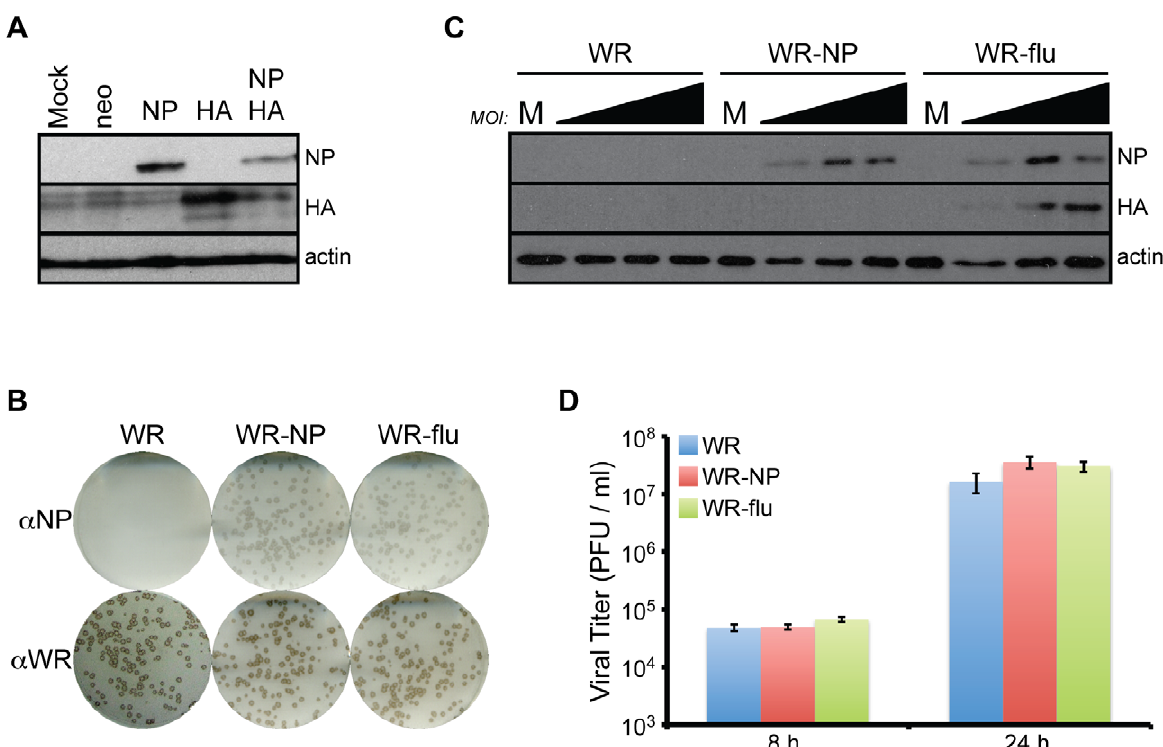
Figure 2. Recombinant viruses synthesize NP and HA proteins and replicate to similar levels. (A) 10 m g of pCIneo (neo) vectors containing the NPmix (NP) or NA-HA (HA) inserts were transfected into BSC40 cells. For double transfections, 5 m g of each vector was used. 48 h post- transfection, cells were lysed and levels of influenza virus proteins were determined using antibodies for NP and HA. (B–D) BSC40 cells were infected with WR, WR-NP, or WR-flu at an MOI of 0.01 (B, D), 0.1, 1, or 10 (C) PFU/cell. (B) At 24 h p.i., cells were fixed and plaques were stained with NP antibody. (C) At 24 h p.i., the levels of NP and HA in the lysates were determined by immunoblot analysis. (D) At 8 or 24 h p.i., infectious virus present in the cells was measured in triplicate standard plaque assay on BSC40